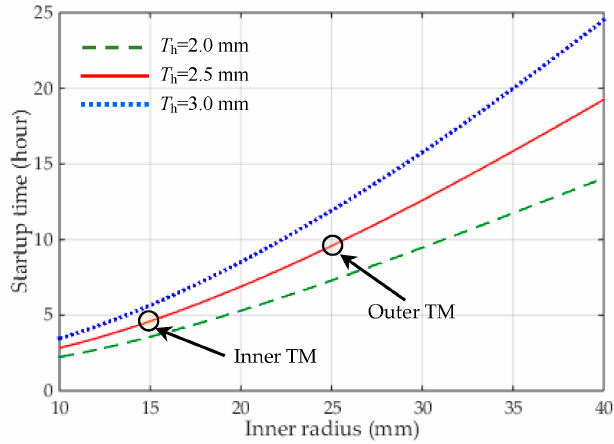
Figure 9. The start-up time of the motor required to spin up from 0 to its rate speed of 10 4 rpm vs. the inner radius of the TM. The thickness of the cylindrical mass T h is set at 2.0, 2.5 and 3.0 mm for